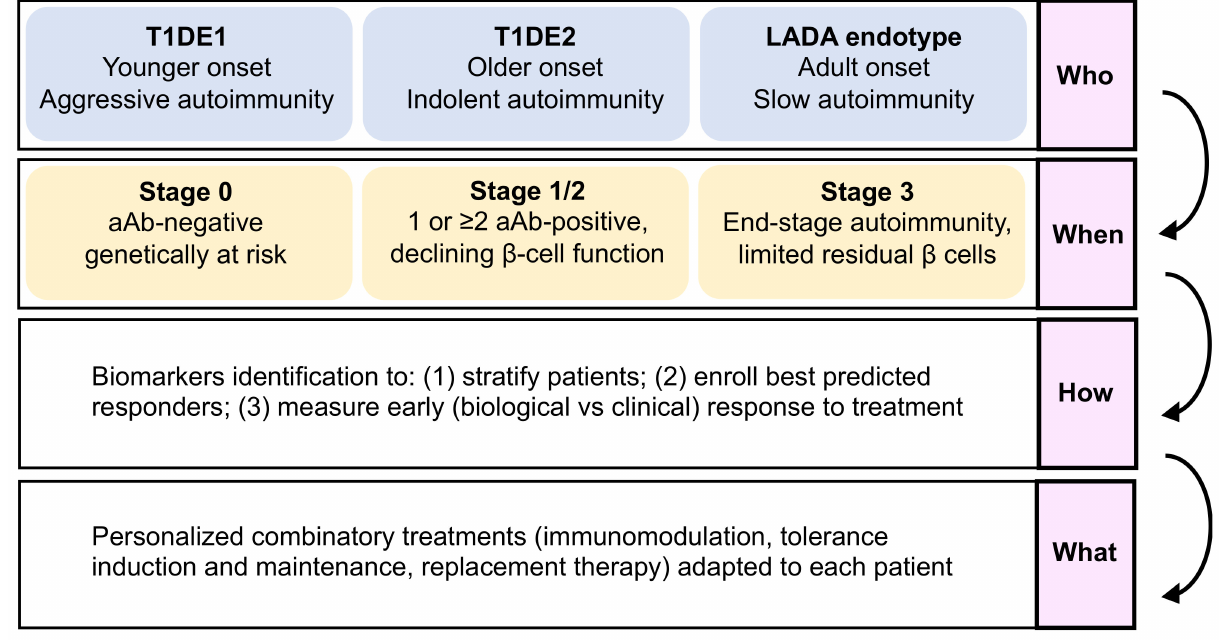
Figure 3. The who, when, how, and what paradigm for T1D (type 1 diabetes) personalized therapy. The first layer of selection for individualized intervention consists in stratifying T1D endotypes, in order